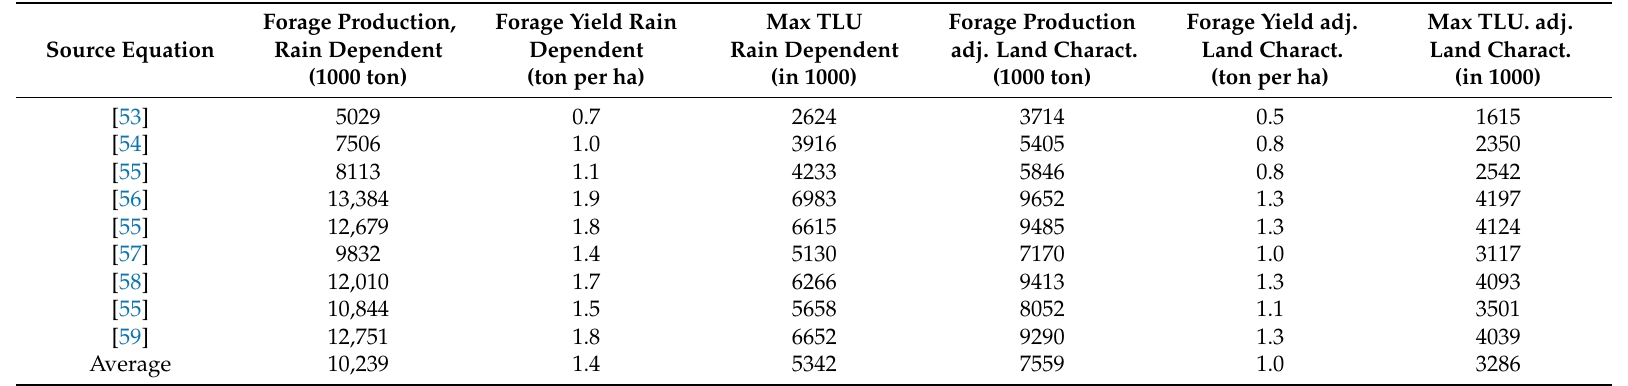
Table 4. Forage production, yield and maximum Tropical Livestock Unit (TLU) estimates for Afar State using rain dependent production functions and rain dependent production functions adjusted for land cover characteristics.